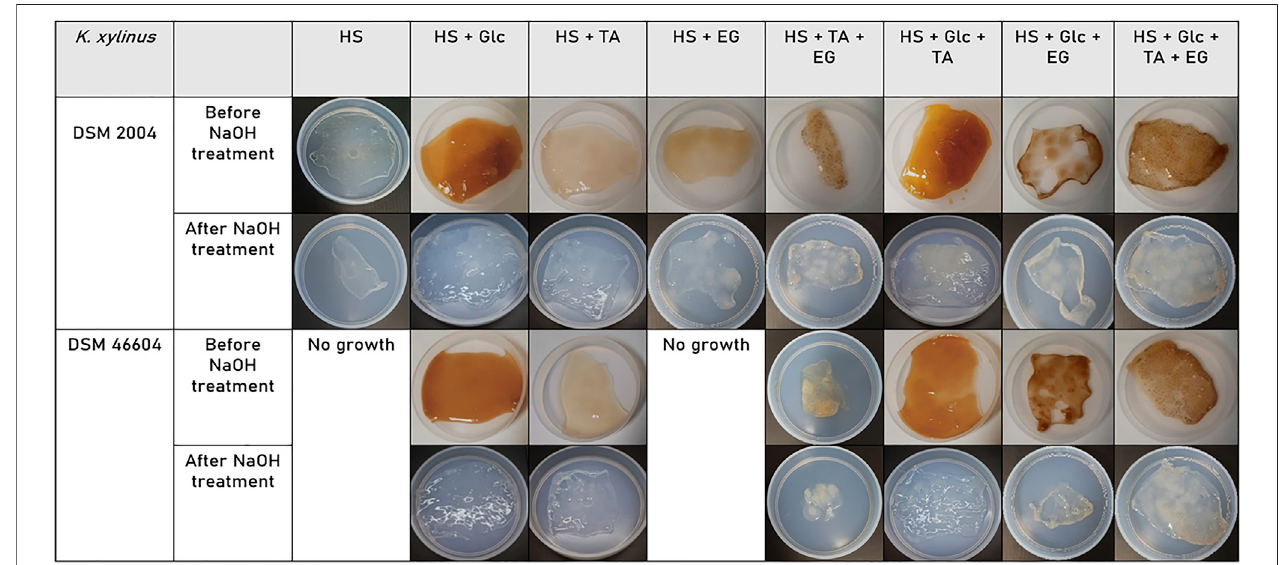
FIGURE2| BCpelliclesproducedbythecultivationof K.xylinus strainsDSM2004andDSM46604ontheHSmediumsupplementedwithglucose,TA,and/orEG.